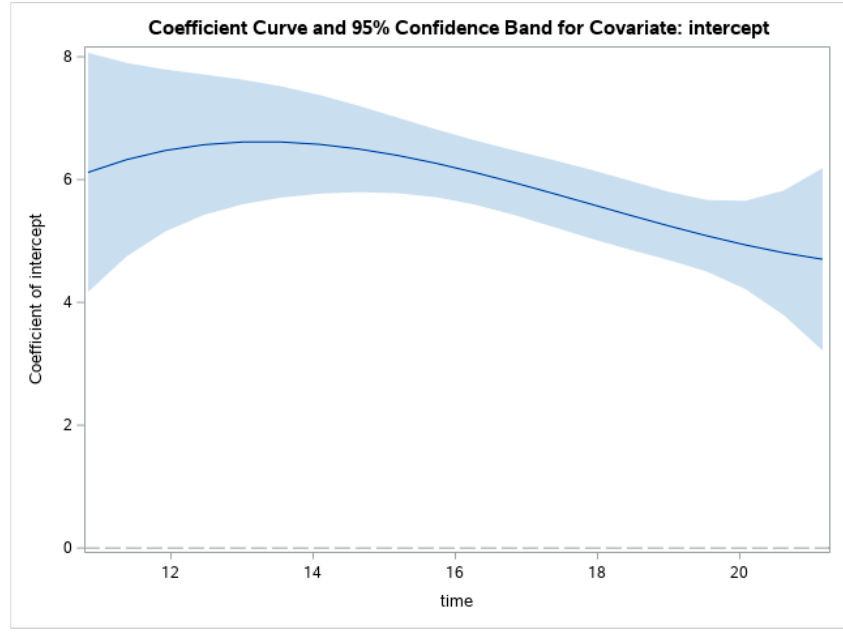
Figure 1. Change in GHQ scores through adolescence for the whole